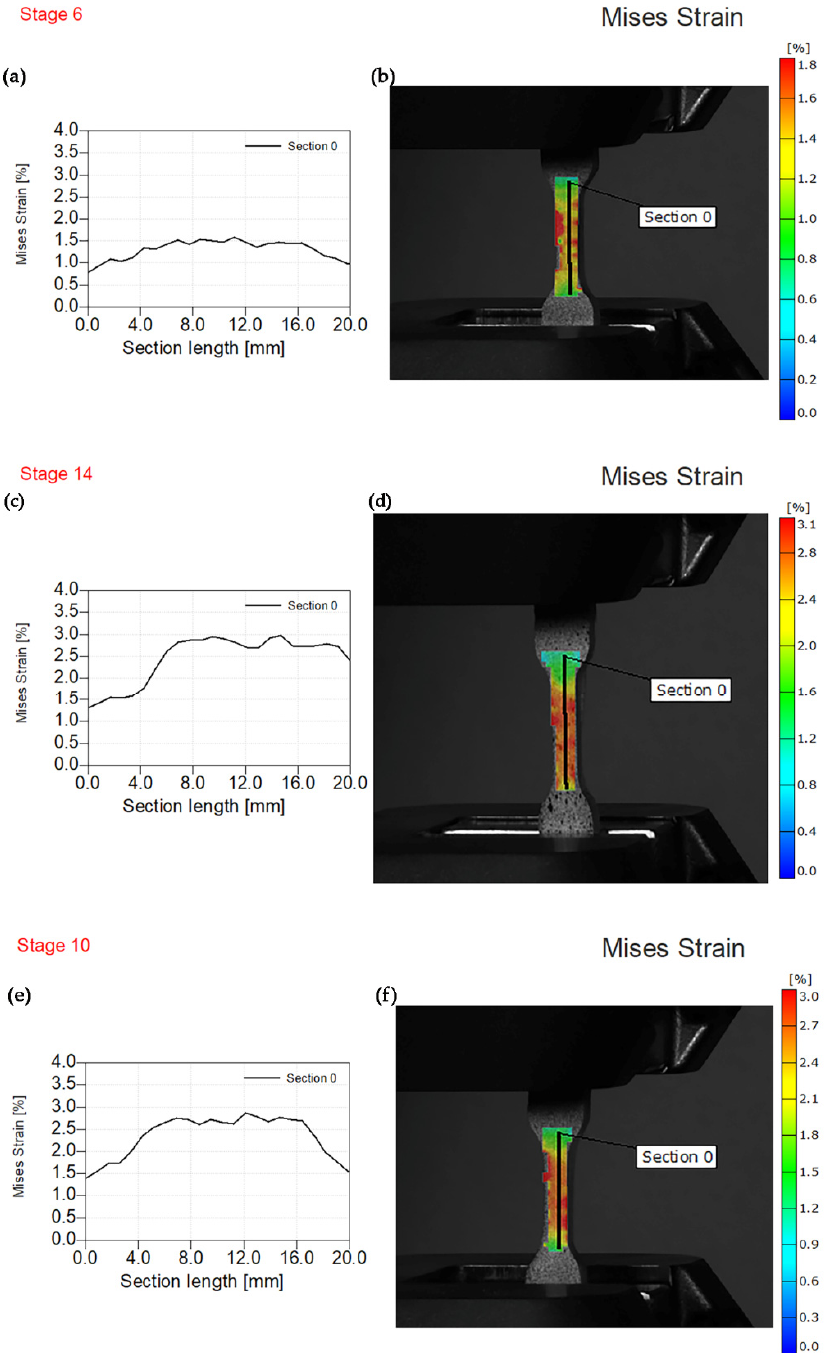
Figure 9. Experimental von Mises strain before fracture. ( a ) Von Mises strain—section length for PE/1DS. ( b ) Sample image PE/1DS with the overlaying von Mises strain field. ( c ) Von Mises strain—section length for PE/2DS. ( d ) Sample image PE/2DS with the overlaying von Mises strain field. ( e ) Von Mises strain—section length for PE/3DS. ( f ) Sample image PE/3DS with the overlaying von Mises strain field.